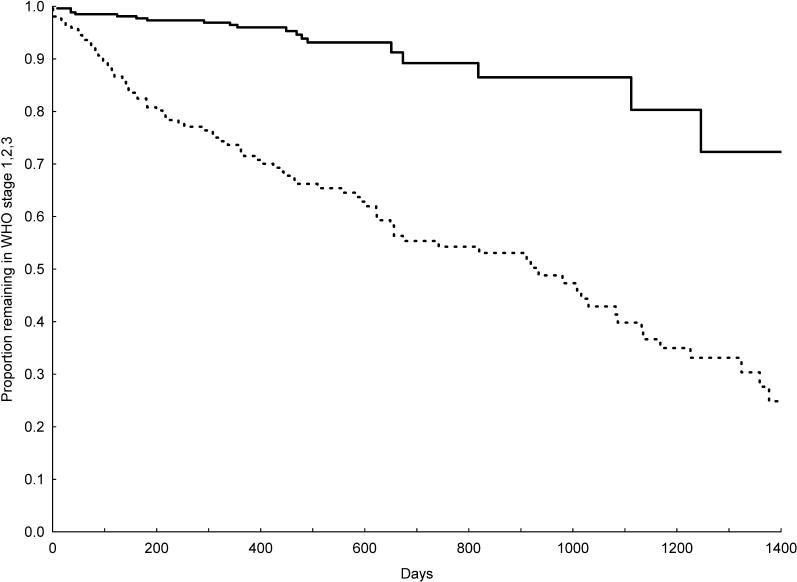
Progression of HIV-Infected Individuals from Non-AIDS Stages (WHO Stage 1, 2, or 3) for Patients on HAART and Not on ARTThe solid line indicates patients on HAART, and the dotted line indicates patients not on ART.